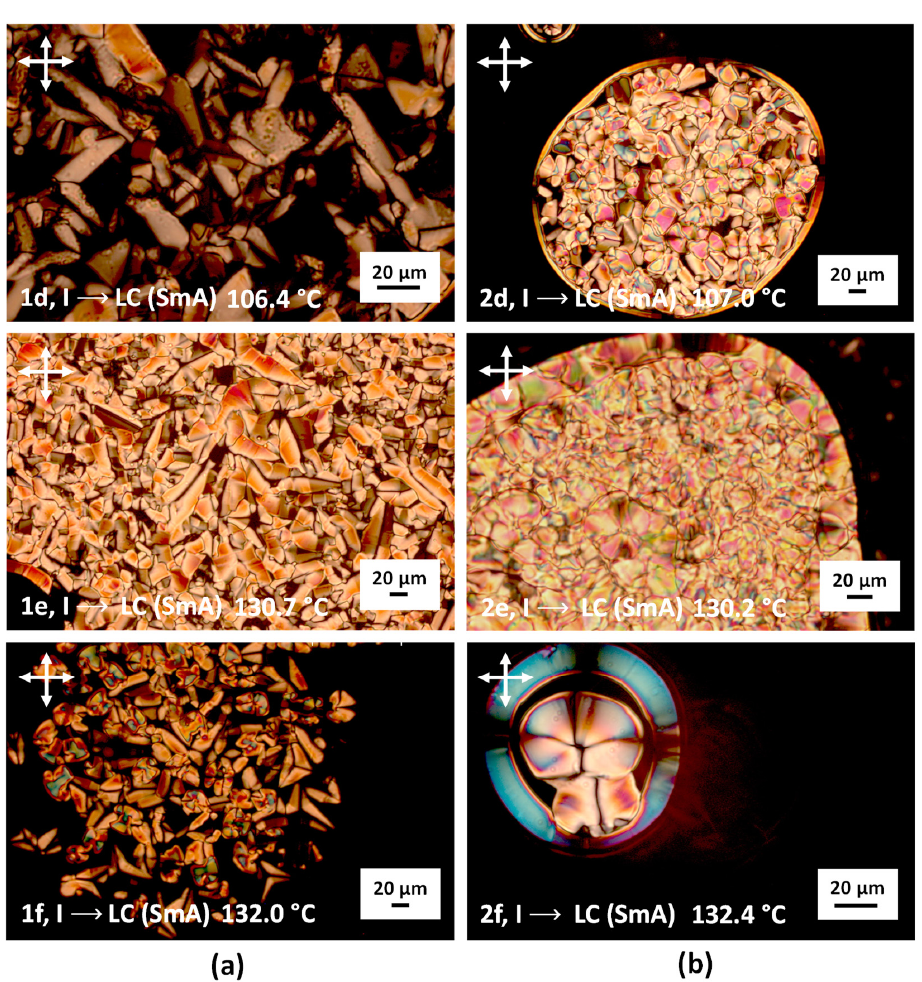
Figure 2. Optical textures of the salts ( a ) 1d at 106.4 ◦ C, 1e at 130.7 ◦ C, 1f at 132.0 ◦ C and ( b ) 2d at 107.0 ◦ C, 2e at 130.2 ◦ C, 2f at 132.4 ◦ C observed by polarized optical microscopy analysis under crossed polarizers showing the mesophase after the 1st transition from the isotropic liquid to the liquid crystalline phase (I −→ LC (SmA)) upon cooling with 10 ◦ C min − 1 . Abbreviation: I, isotropic phase; LC, liquid crystalline phase; SmA, smectic A phase.